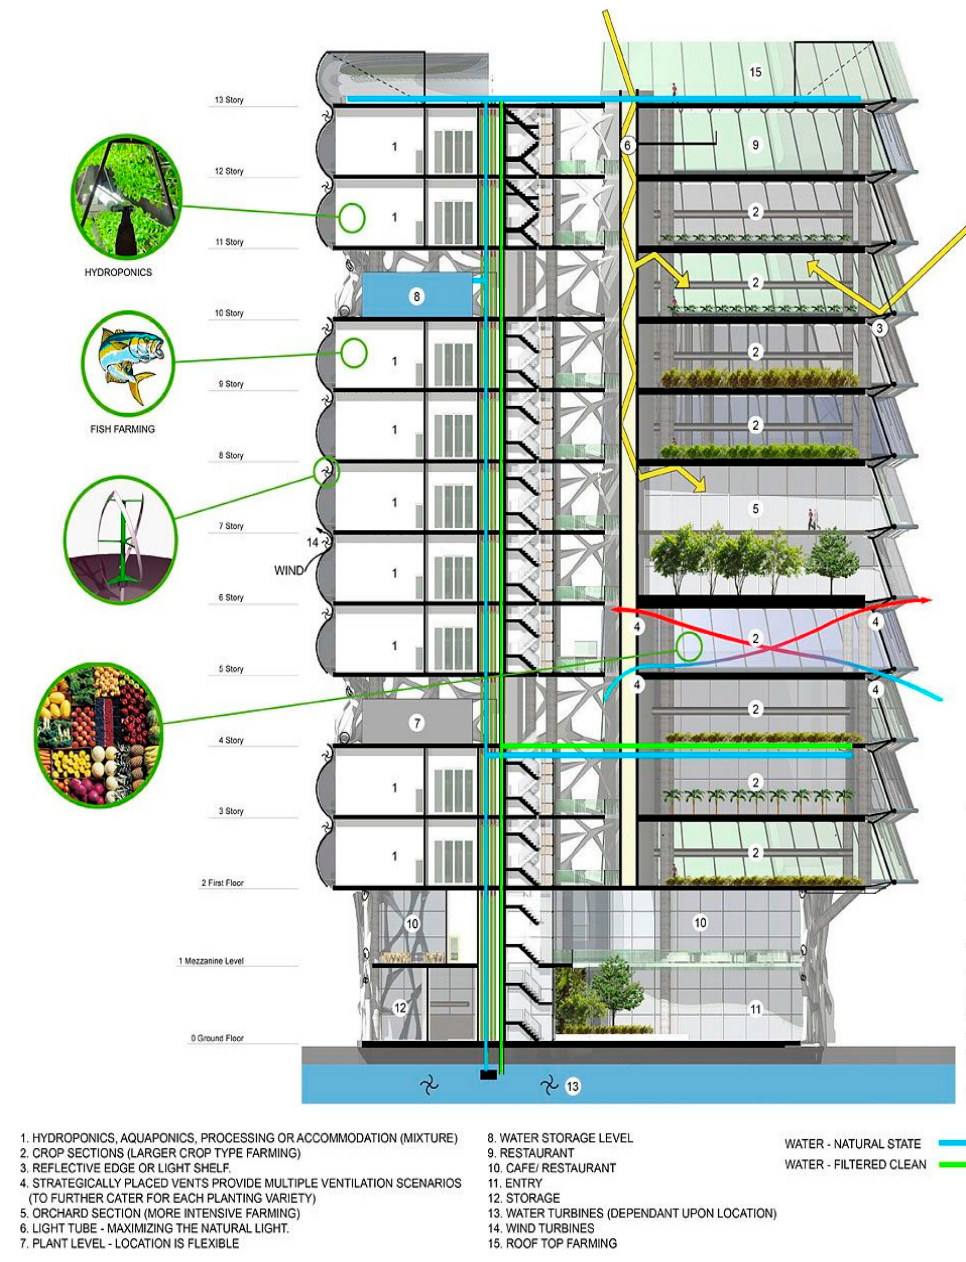
Figure 5. Concept of vertical Skyfarm technology. Reprinted from ref. [17].